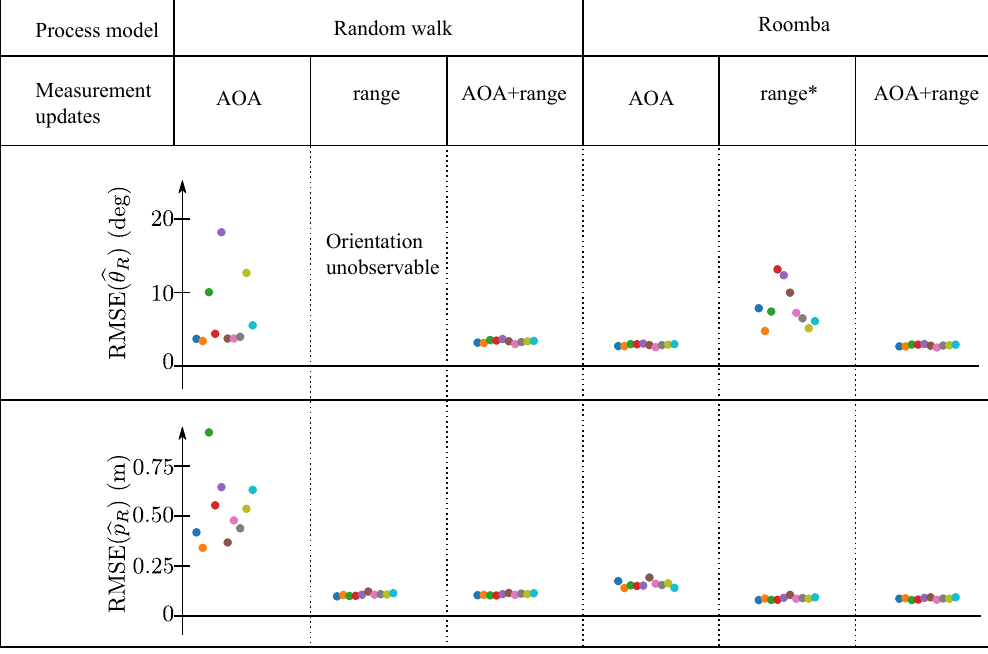
Figure 9. This figure compares the performance of particle filters having different process models and different measurement updates. The root mean square error (RMSE) obtained for the ten different leave-one-out cross-validation evaluations are shown in different colors. The neural networks employed by the particle filters using AOA measurement updates were trained with datasets in which the AOA corresponding to a CIR measurement was provided by a particle filter employing the Roomba process model and range measurement updates (see the column marked with * for its